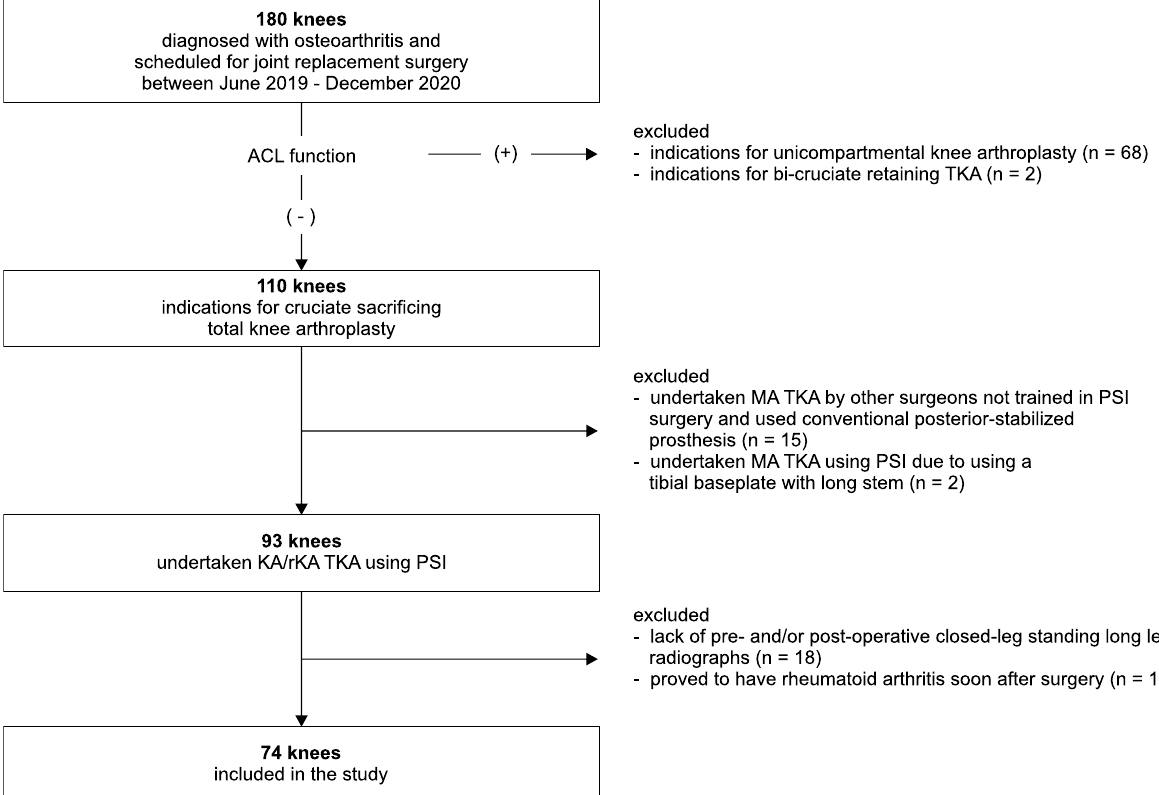
Fig. 1 Flowchart of inclusion and exclusion criteria. The inclusion criteria for this study were patients who had undergone primary TKA using the rKA method with CT-based PSI and with pre- and post-operative long-leg radiograph taken at our facility. Patients with rheumatoid arthritis, who had undergone arthroplasty using conventional alignment methods or other technology assistance, and without long-leg radiographs were excluded. Abbreviations: ACL: anterior cruciate ligament; KA: kinematic alignment; MA: mechanical alignment; PSI: patient-specific instrument; rKA: restricted kinematically alignment; TKA: total knee